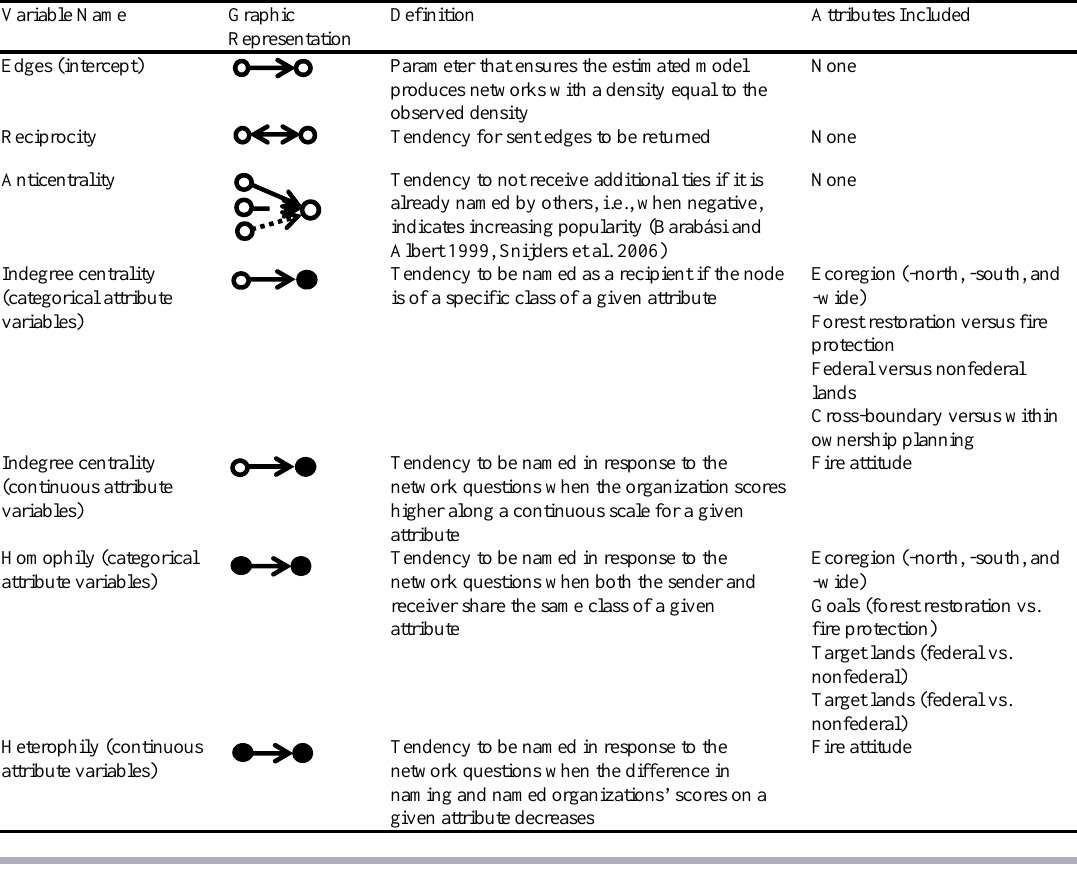
Table 1 . Variables used in exponential random graph model.